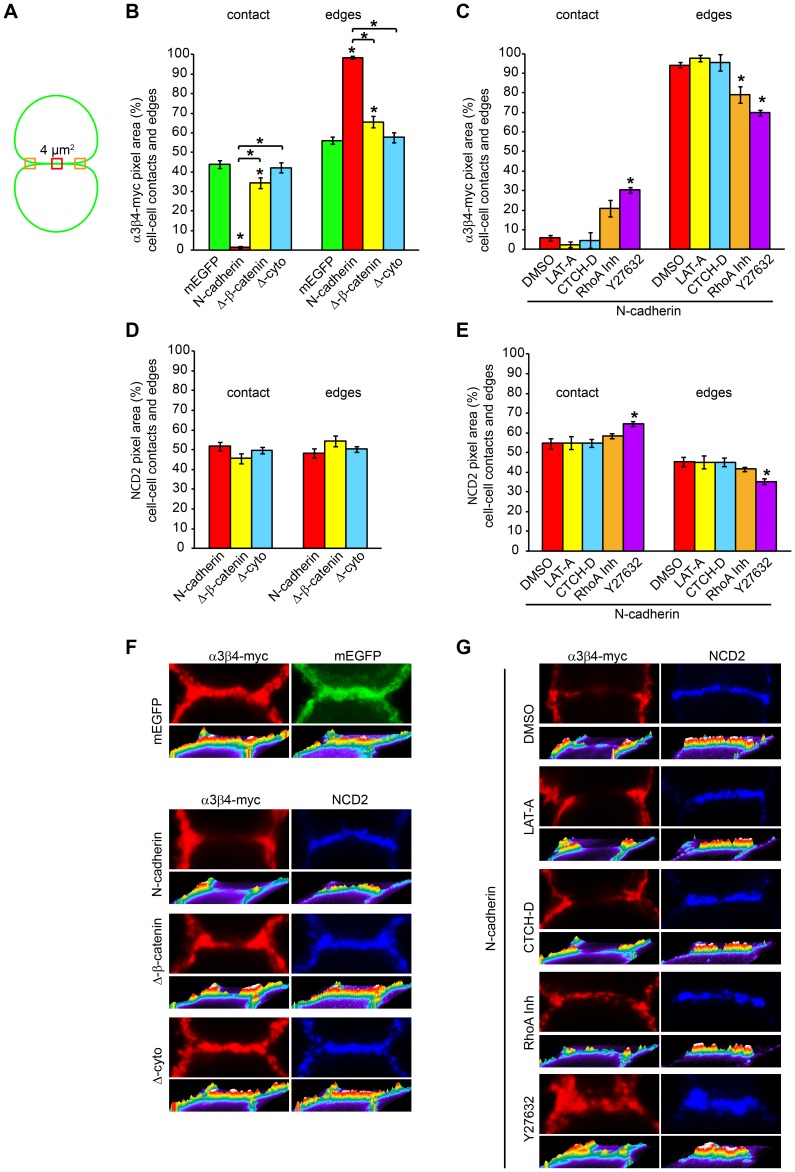
N-cadherin homotypic binding promotes α3β4-myc nAChRs localization at the edges of the cell-cell contact.A) Schematic drawing of two contacting cells showing the areas of the cell surface in which α3β4-myc nAChRs and N-cadherin pixel area was measured in 2×2 µm regions placed at the center (red) and at each of the edges of the cell-cell contact (orange). The average of the two measurements of the edges was used for analysis, and the sum of the measurements at the center and edges at the cell-cell contact was considered 100%. B) Analysis of the percentage of α3β4-myc nAChRs pixel area distribution between the center and the edges of cell-cell contacts in cell junctions mediated by mEGFP (n = 24), N-cadherin (n = 22), N-cadherin-Δ-β-catenin (n = 25), and N-cadherin-Δ-cyto (n = 27). C) Analysis of the effect of inhibitors of actin polymerization (LAT-A 10 µM, n = 21; and CTCH-D 2 µM, n = 16), RhoA (RhoA Inh 1 µg/ml, n = 21), and ROCK (Y27632 10 µM, n = 21) on α3β4-myc nAChRs density at the contact and edges of N-cadherin-mediated cell-cell contacts. Cells treated with DMSO (10 µl/ml, n = 20) were used as controls. D) Analysis of the percentage distribution of N-cadherin and N-cadherin-deleted proteins between the cell-cell contact and the edges of contact zone. E) Analysis of the effect of DMSO, LAT-A, CTCH-D, RhoA Inh, and Y27632 on N-cadherin density at the contact zone and at the edges of cell-cell contacts. Values in B, C, D, and E represent the mean ± SEM of each experimental group. One-way ANOVA of pixel density in cell-cell contacts and the edges of the contact in B and C, p<0.001; post-hoc Bonferroni test comparisons with cells transfected with mEGFP (B) and cells treated with DMSO (C), *p<0.05. Bars with an asterisk indicate post-hoc Bonferroni test comparison between the two indicated groups, p<0.05. One-way ANOVA in C, p>0.05. One-way ANOVA in D, p<0.001, post-hoc Bonferroni test comparisons with DMSO treated cells, *p<0.05. F and G) Representative confocal images of the cell-cell contact area of CHO cells expressing α3β4-myc nAChRs and mEGFP, N-cadherin, N-cadherin-Δ-β-catenin, or N-cadherin-Δ-cyto (F), and of CHO cells expressing α3β4-myc nAChRs and N-cadherin and treated with the indicated drugs (G). Cells were immunolabeled with anti-myc (9B11) and anti-N-cadherin (NCD2) antibodies. The images show the fluorescence signal (above) and the intensity profile (below) for each fluorophore.